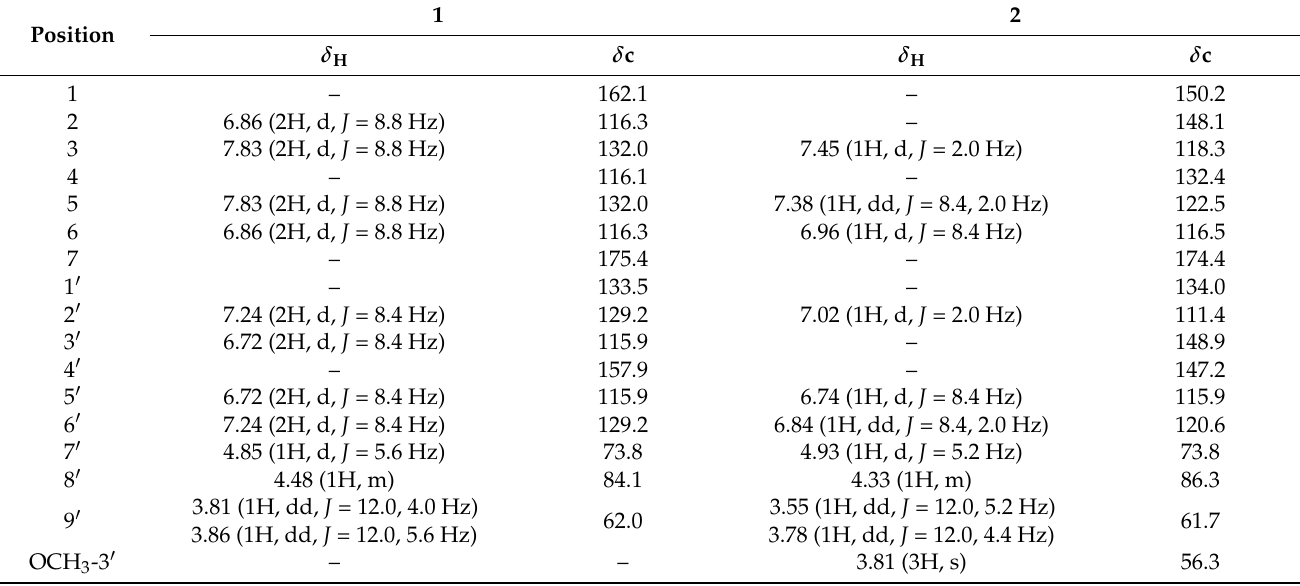
Table 1. 1 H and 13 C NMR spectroscopic data of compounds 1 and 2